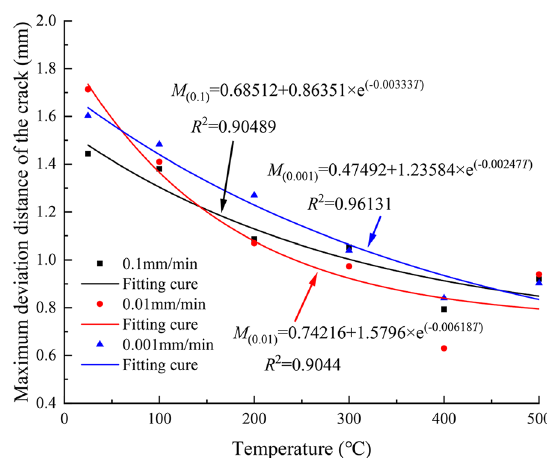
Fig. 9 Maximum deviation distance of the crack at different